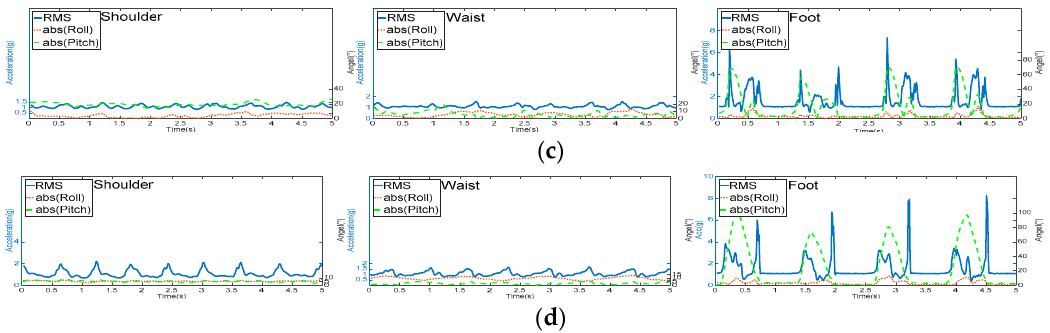
Figure 10. RMS and absolute value of roll and pitch distribution on the shoulder, waist, and foot during ADLs: ( a ) Bending over; ( b ) Staggering forward; ( c ) Walking; ( d ) Taking stairs.